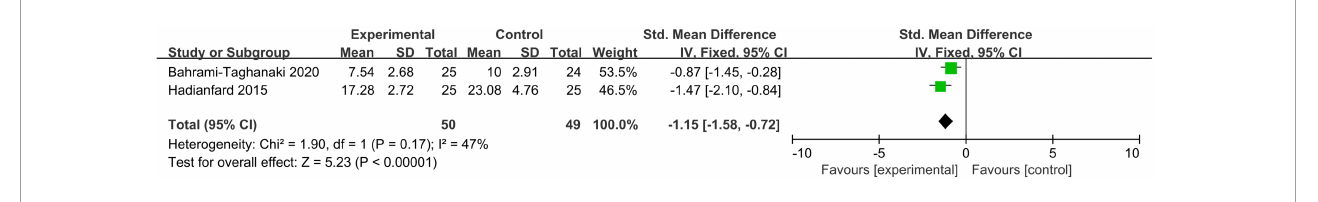
FIGURE4 A meta-analysis of symptom severity of acupuncture plus night splints vs. medicine plus night